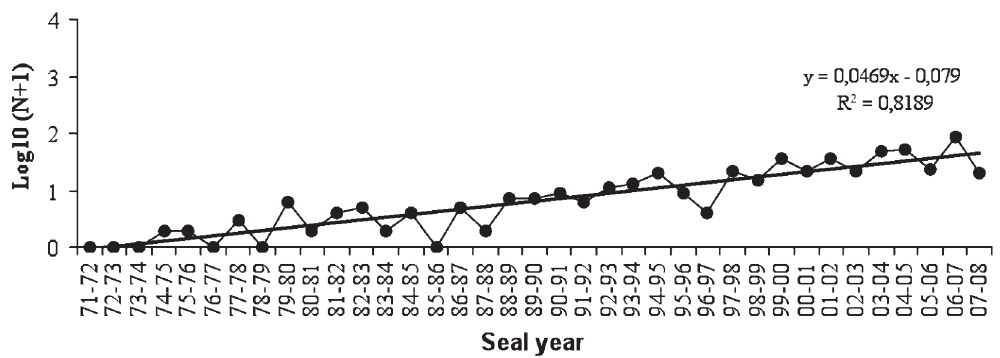
Fig. 8 . Logarithmic function of admitted orphaned grey seals per seal